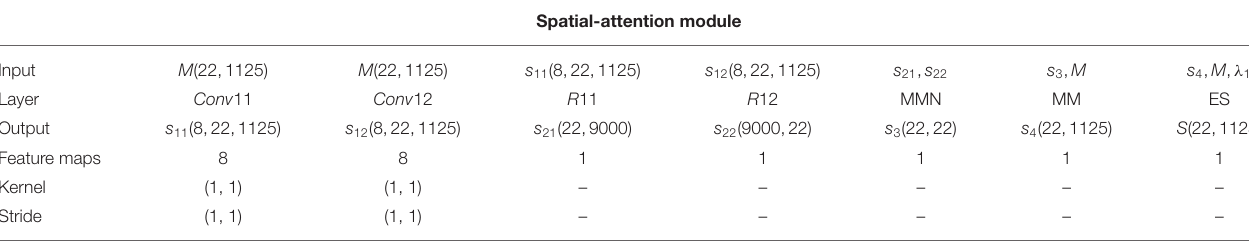
TABLE 1 | Detailed architecture of the proposed spatial self-attention module.